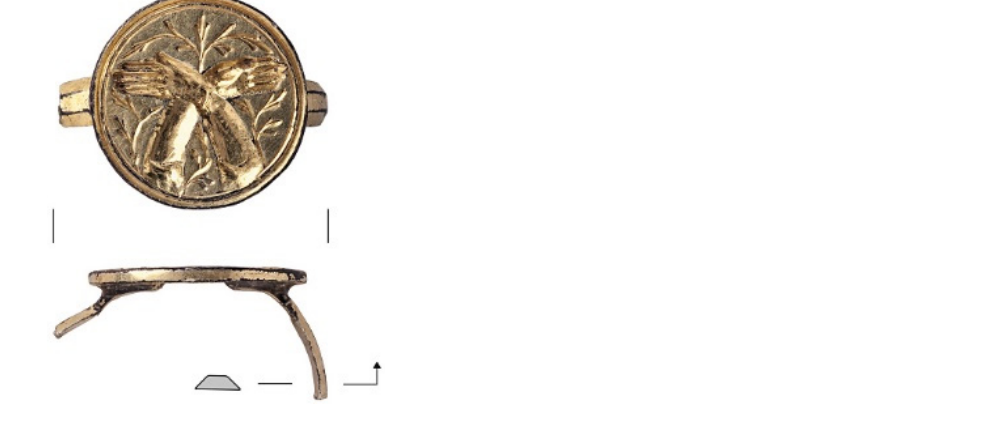
Figure 19. Treasure from Wiener Neustadt. Finger ring with “crossed hands” motif, 13th/14th century. Photo: Paul Kolp; editing: Franz Siegmeth.